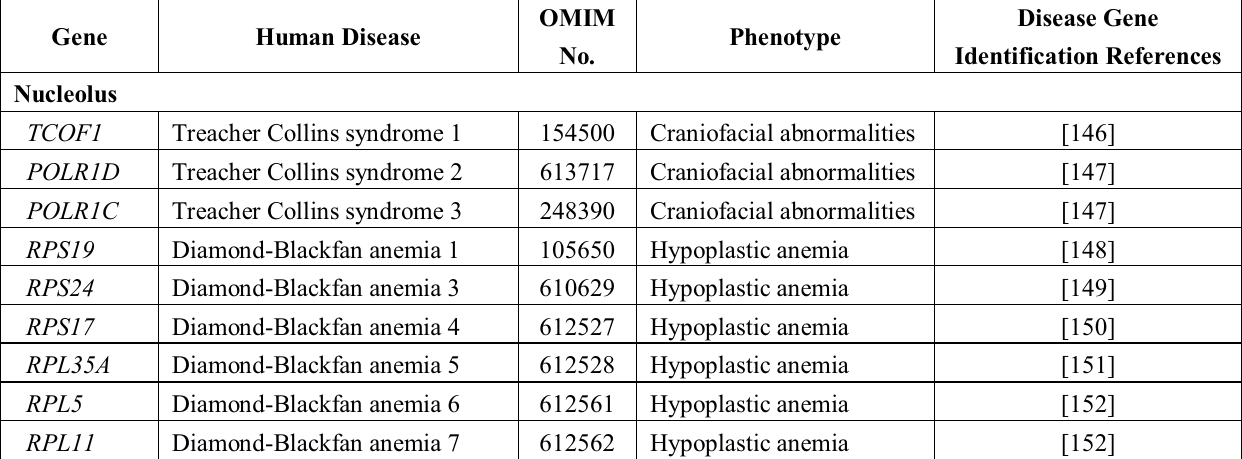
Table 3. Selected human diseases associated with mutations in genes encoding nuclear body